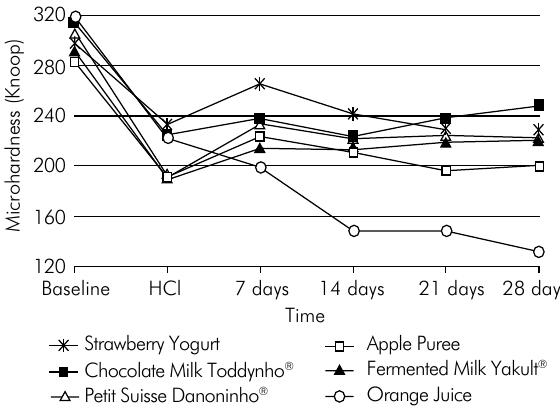
Figure. Mean surface microhardness of each snack according to length of exposure.